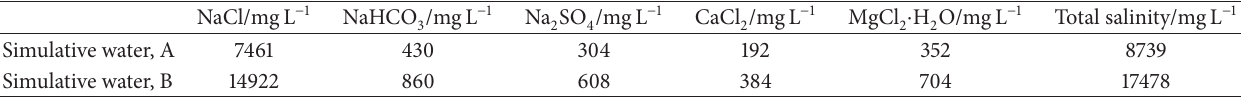
Table 1: The components of simulative water of SZ